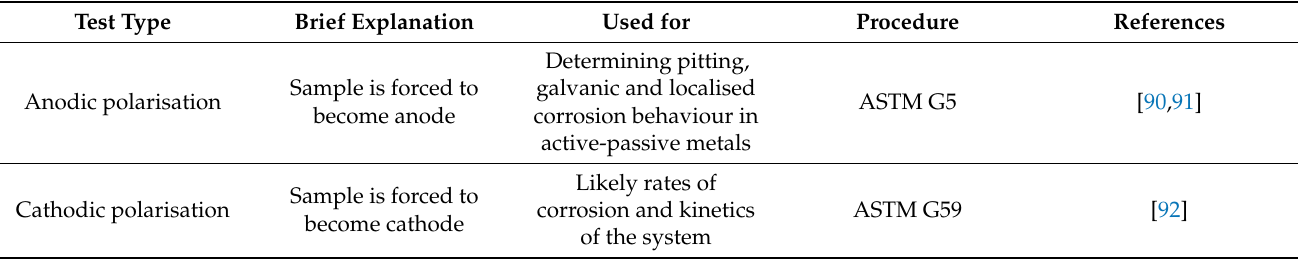
Table 6. Potentiodynamic polarisation